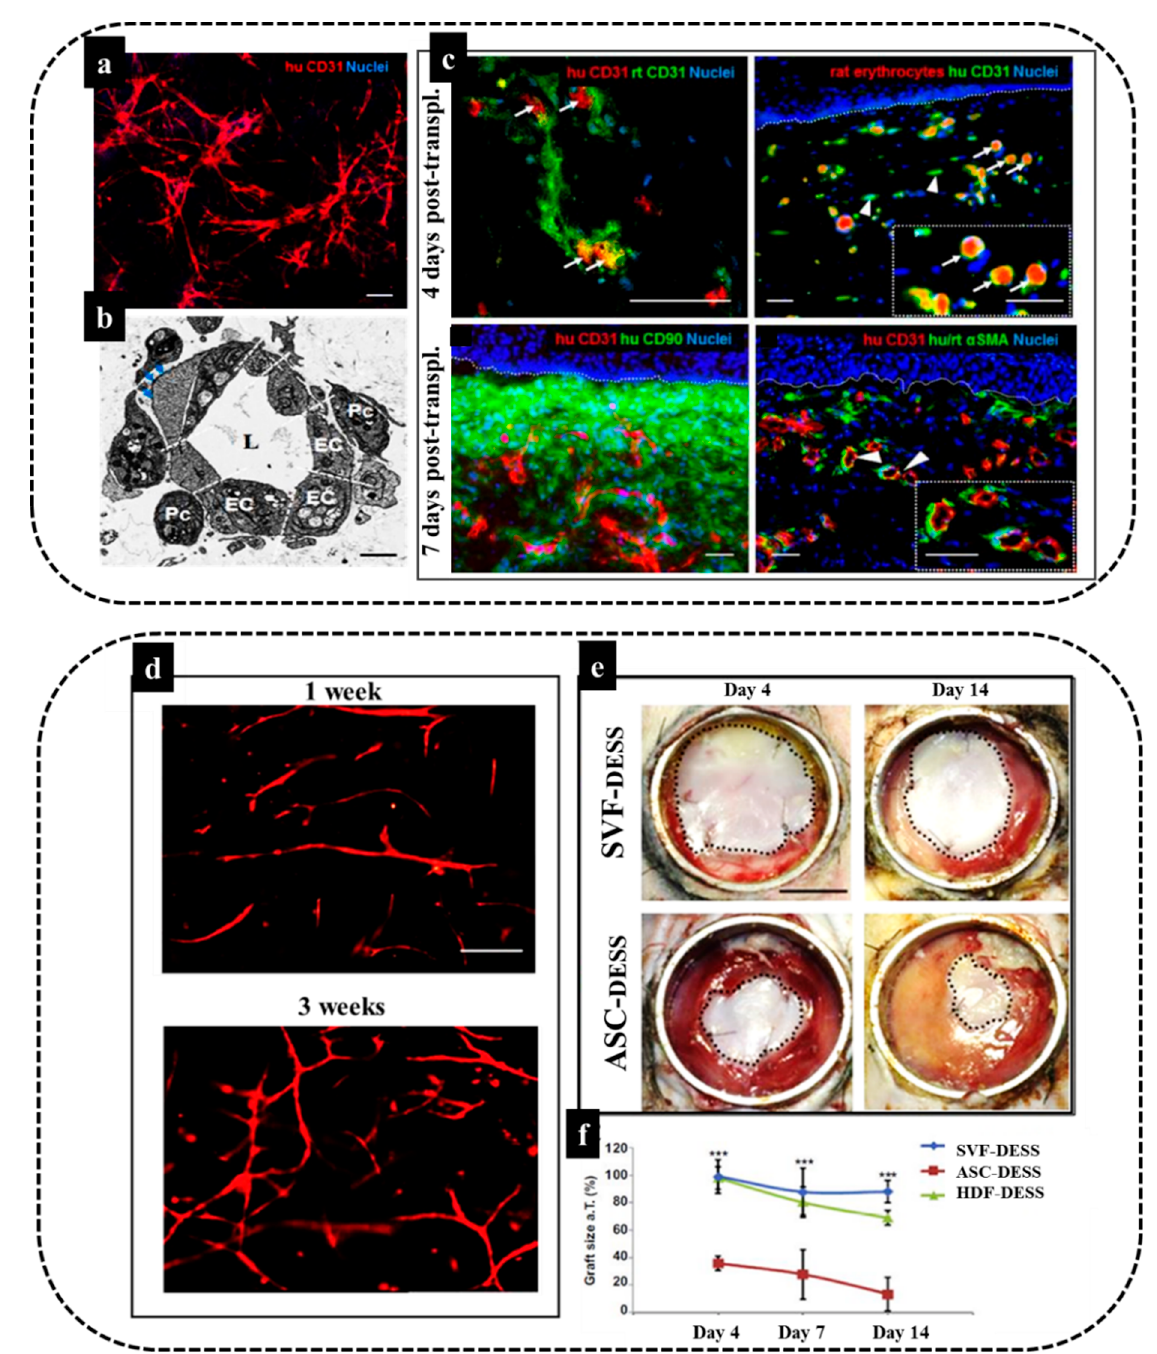
Figure 5. Engineering of dermo-epidermal skin substitutes with adipose-SVF cells. ( a , b ) Endothelial cells derived from freshly isolated SVF and perivascular cells in fibrin–collagen type I hydrogel demonstrate in vitro tubular-like structure formation and in vivo anastomosis with the host vasculature. Formation of a complex network of interconnected capillaries after 21 days in culture. Human bioengineered capillaries are stained for human-specific CD31 marker (red) and cell nuclei with Hoechst (blue) and transmission electron microscopy showing a cross-section of an in vitro grown capillary. Note the presence of a central lumen (L), which is surrounded by multiple ECs (EC) covered by pericytes (Pc). The deposition of basement membrane (BM) (blue arrows) was also detected. ( c ) Establishment of a functional connection (white arrows) between human CD31-positive capillaries (red) and rat CD31-positive capillaries (green) already 4 days post-transplantation. This connection was further confirmed by the presence of rat erythrocytes (red autofluorescence) in the lumina of human CD31-positive capillaries (green) (white arrows). The inset shows a magnification of the area indicated by white arrows. White arrowheads indicate nonperfused human capillaries.